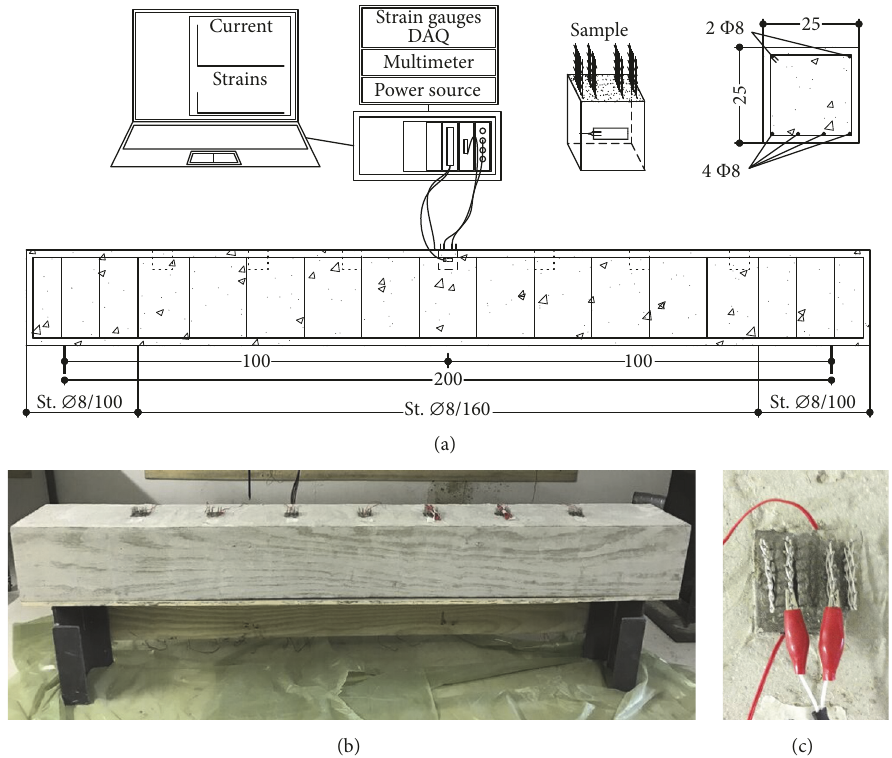
Figure 4: Sketch of the full-scale beam test setup (a); picture of the beam with the embedded sensors (b); detailed view of the sensors at the midspan (c).